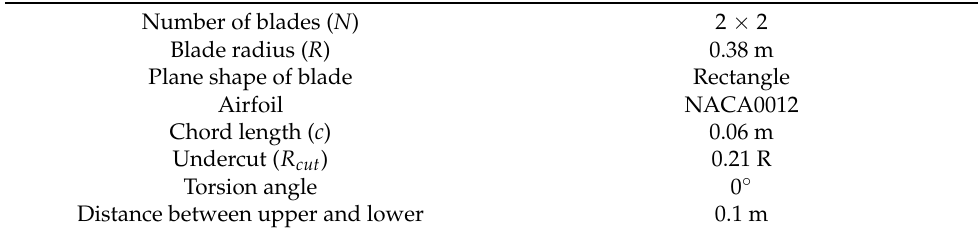
Table 1. Detailed parameters of NASA coaxial rotor.